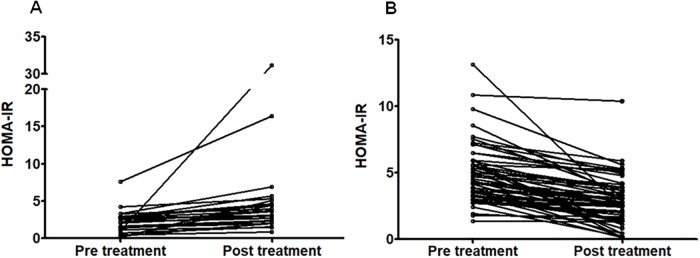
Individual homeostasis model assessment: Insulin resistance (HOMA-IR) values before and after antiviral treatment of hepatitis C.Panel A: patients whose HOMA-IR values increased after treatment (N. = 26); panel B: patients whose HOMA-IR values decreased after treatment (N. = 56).